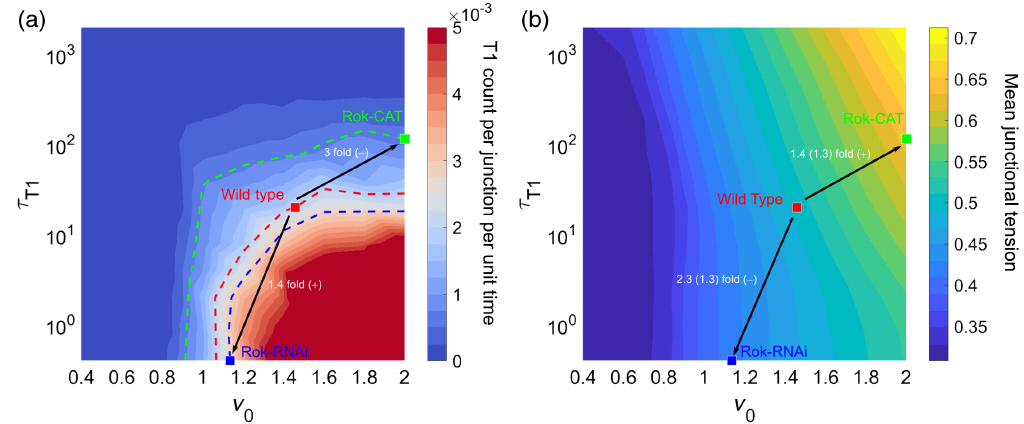
FIG. 7. DVM makes a qualitatively consistent prediction of the trends of T1 rates and junctional tension observed during the development of Drosophila pupal notum by Curran and co-workers in Ref. [16]. (a) Color map of T1 rates predicted by DVM. Contours representing the experimental T1 rates are marked by dashed lines (wild-type, red; Rok-CAT, green; Rok-RNAi, blue). To map the experimental T1 rates from Ref. [16] on our model-predicted T1 rates, we make the former dimensionless (see Appendix A for details). (b) Color map of tensions predicted by DVM. Both panels show the DVM-predicted transition paths from the wild-type to the perturbation scenarios on the v 0 − τ plane. We also show the experimentally observed fold changes of T1 rate (a) and tension (b) in the T 1 two perturbations from the wild type. In (b), the numbers in parentheses are the corresponding fold changes predicted by DVM for tensions. þ or − within parentheses indicates increase or decrease,